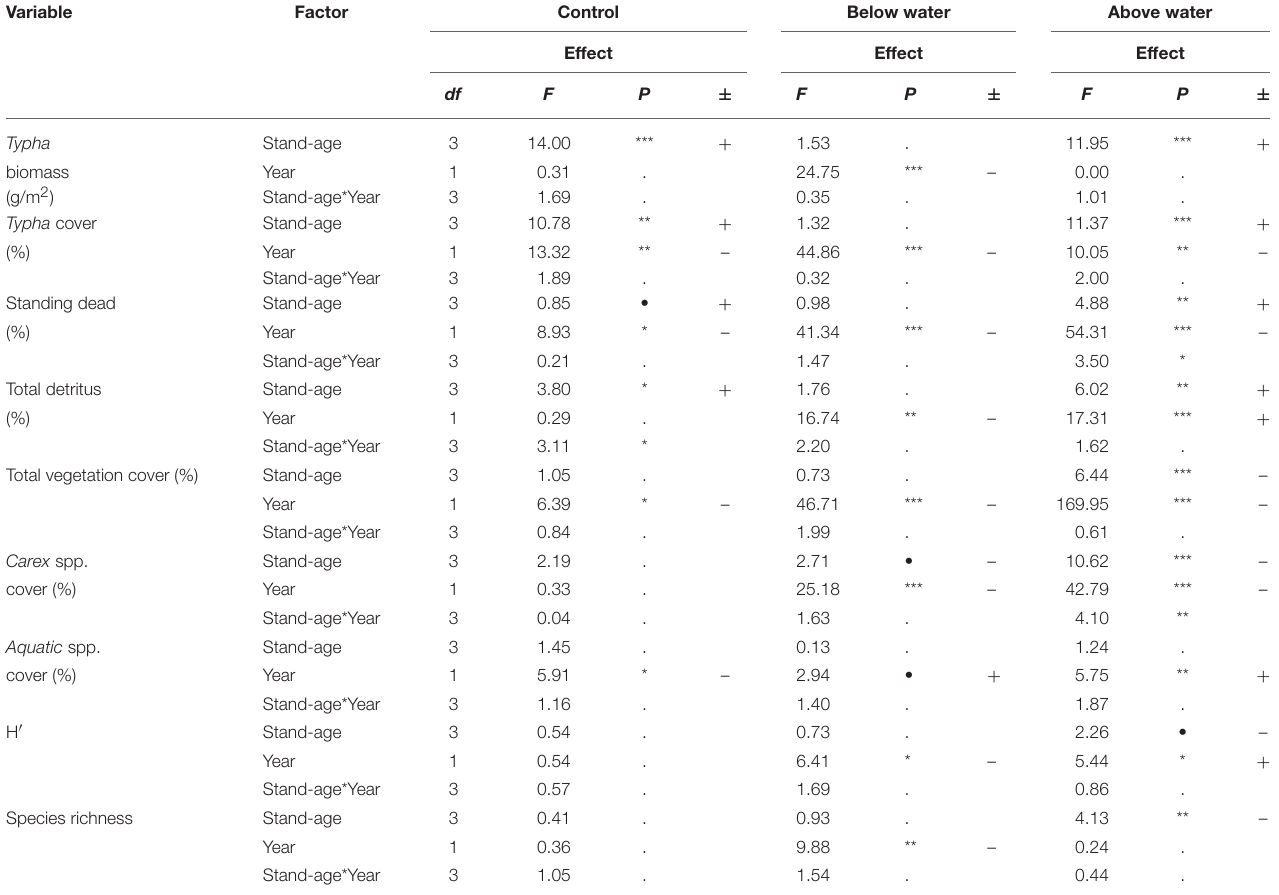
TABLE 5 | Results of linear mixed effects model (with Typha stand as a source of random effects) evaluating the effects of stand-age and Year (pre-treatment in year-1) on plant and environmental conditions. Variable Factor Control Below water Above water Effect Effect